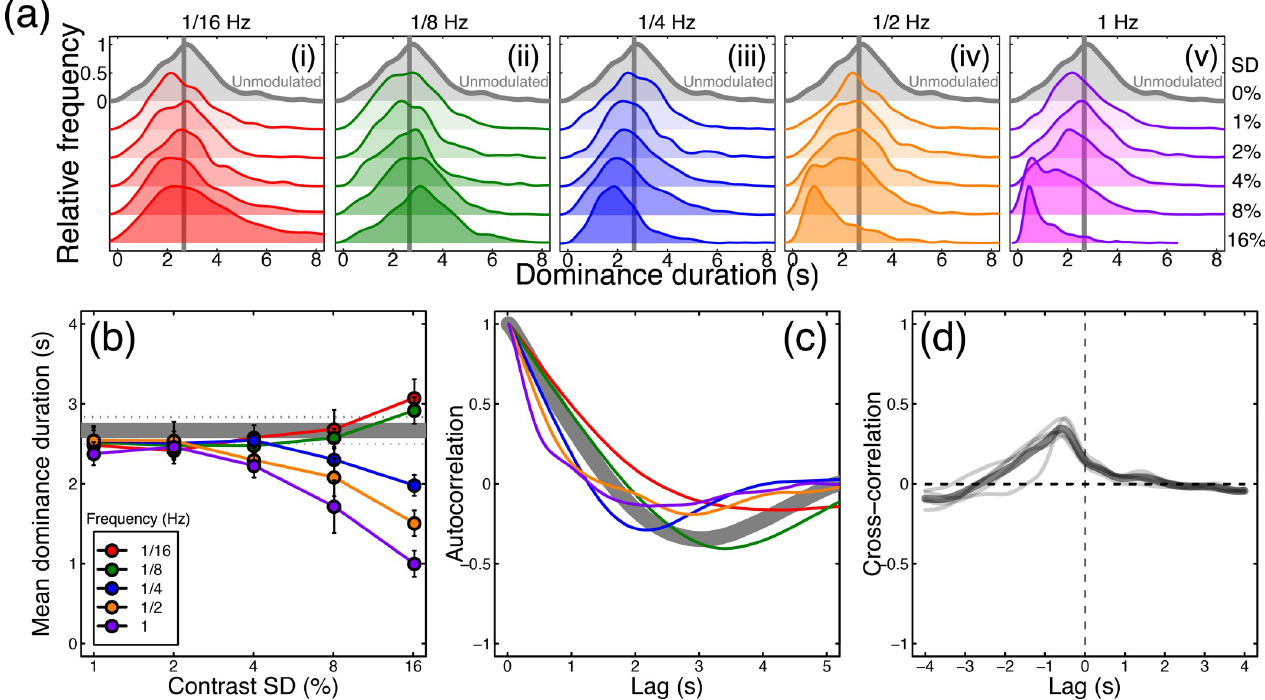
Fig 3. Traditional rivalry measures for all conditions, averaged (or pooled) across all participants (N = 5). Panel (a) shows histograms of pooled dominance durations at five temporal frequencies (i-v) and a range of contrast levels (standard deviations of 0–16% contrast, increasing down each plot). The grey histogram, duplicated in each plot, shows the baseline condition with no contrast modulation. For low temporal frequency, high contrast modulations, there were more very long dominance periods (the positive skew of the red histogram increases). For high temporal frequency, high contrast modulations there were more short dominance periods, and the histograms shifted left. Panel (b) shows mean dominance durations for all conditions, plotted as a function of modulation contrast. The grey horizontal line shows the baseline (no modulation) condition. Error bars (and dotted lines) show ± 1SE across participants. Panel (c) shows autocorrelation functions (e.g. the correlation between a participant’s percept at a given moment, as in Fig 1C, with their percept at subsequent moments) averaged across participants for the baseline condition (grey curve) and the highest contrast modulation at each temporal frequency (curves, see panels a,b for colour legends). Panel (d) shows the cross correlation between the participants’ responses and the difference in noise modulations at the highest modulation contrast, averaged across all modulation frequencies. The thin grey lines denote individual participants and the thick black line is the